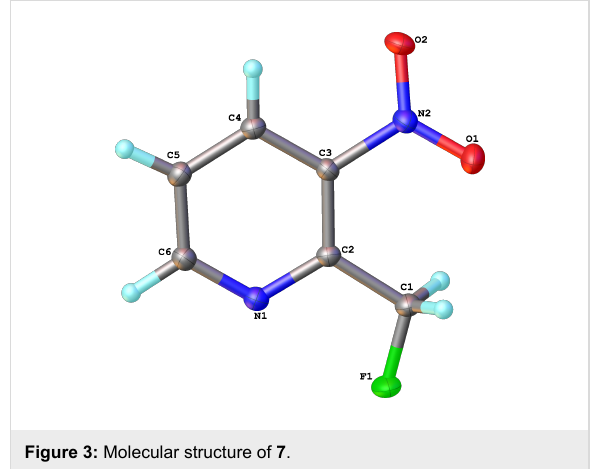
Figure 3: Molecular structure of 7 .